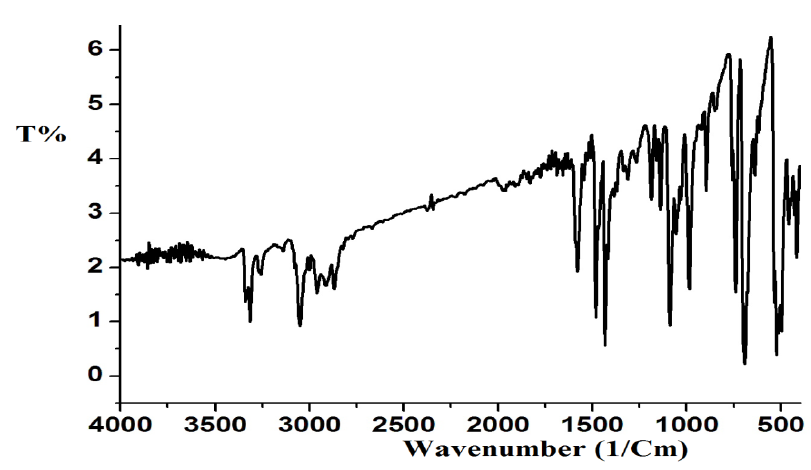
Figure 3. IR spectrum of complex 1 .